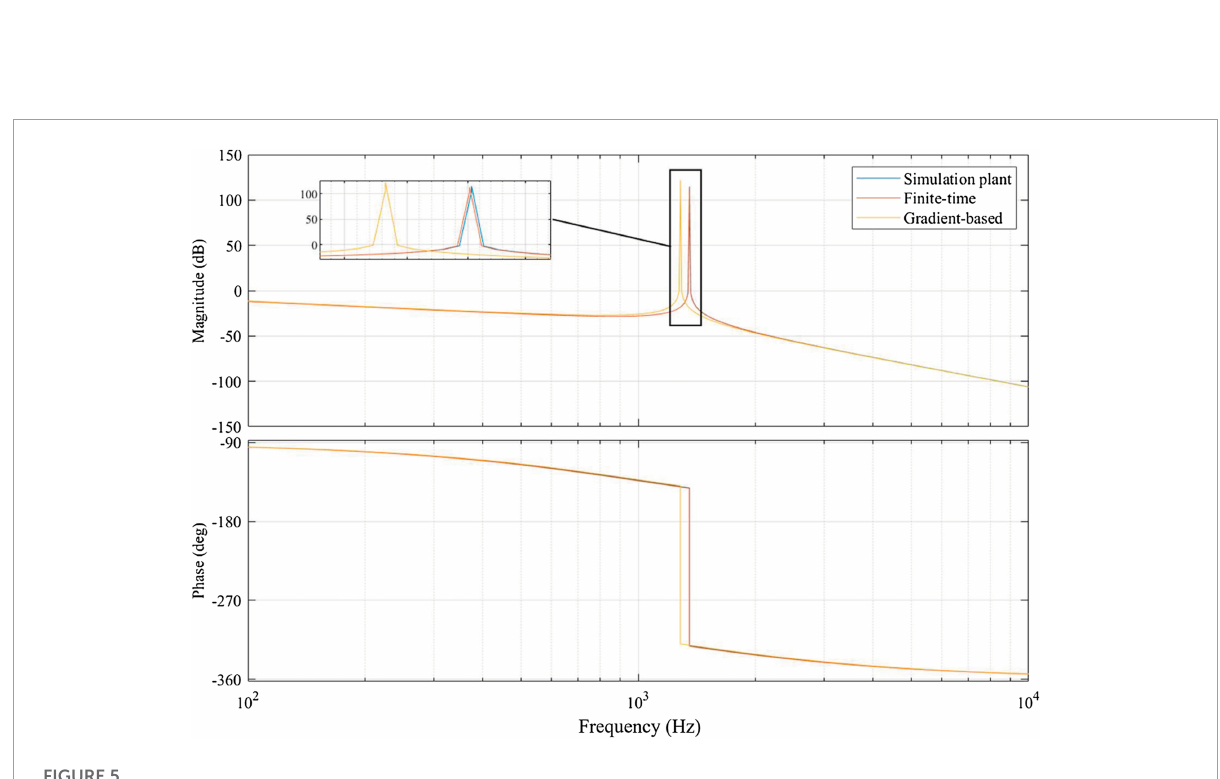
FIGURE 5 Frequency responses of LCL filter with two estimation